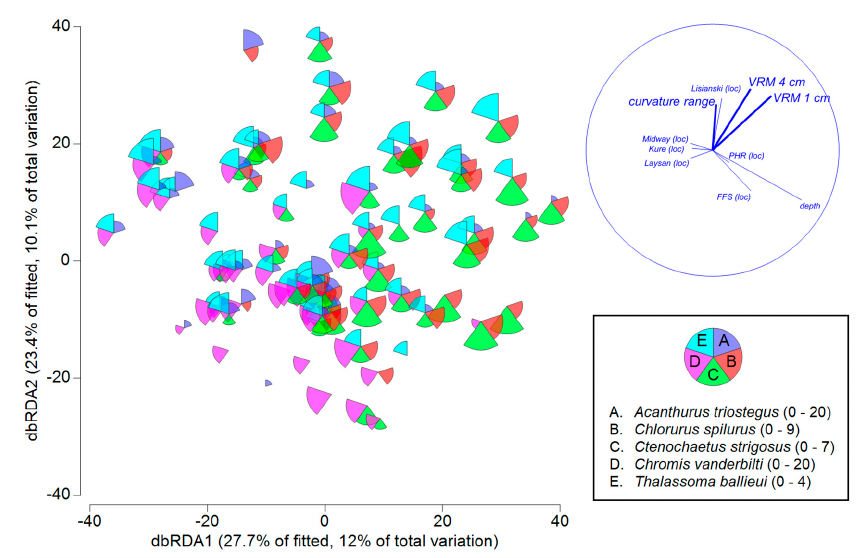
Figure 6. Ordination generated by distance-based redundancy analysis (dbRDA) for the fitted model of the fish data from the 80 survey sites based on Bray-Curtis dissimilarity after square-root transformation of fish abundance versus the five explanatory variables: geographical locations (island/atoll names with “(loc)”), depth, standardized mean VRM at 1-cm resolution (VRM 1 cm), standardized mean VRM deviation at 4-cm resolution (VRM 4 cm) and standardized curvature range (curvature range). The strengths of the relationships between each explanatory variable and the dbRDA axes (dbRDA1 and dbRDA2) are shown as vectors at the top right. The abundances of the five fish species (A–E) are shown by the sizes of pies. The range fish abundance after square-root transformation is shown for each species in the parentheses next to the species name on the bottom right of the